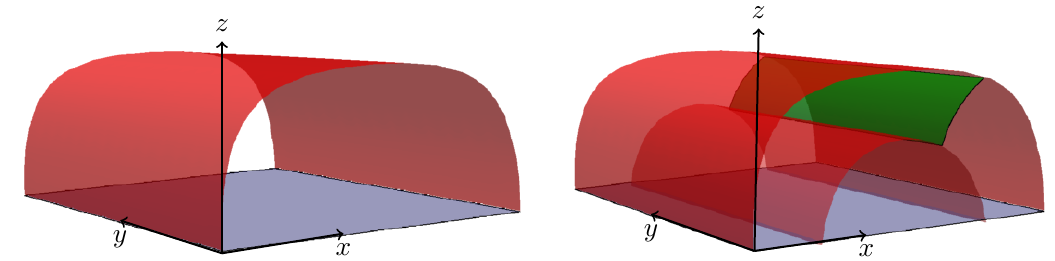
Figure 4 . Left plot: the minimum surface for a subsystem (red region). Right plot: the minimum cross-section (green surface) of the entanglement